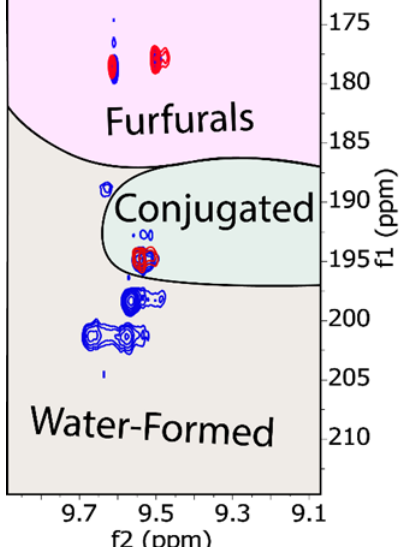
Figure 5. Magnified HSQC spectra of PFA+ (blue) and PFA° (red) focusing on the aldehyde region. The PFA° spectrum is presented on top of the PFA+ spectrum.